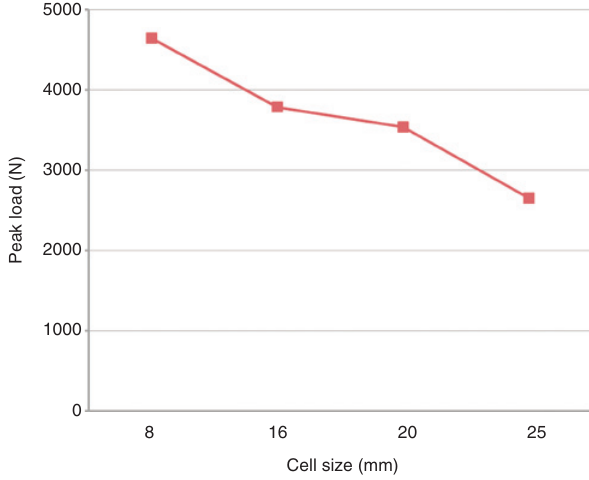
Figure 9 Peak load of sandwich panel of different cell size during